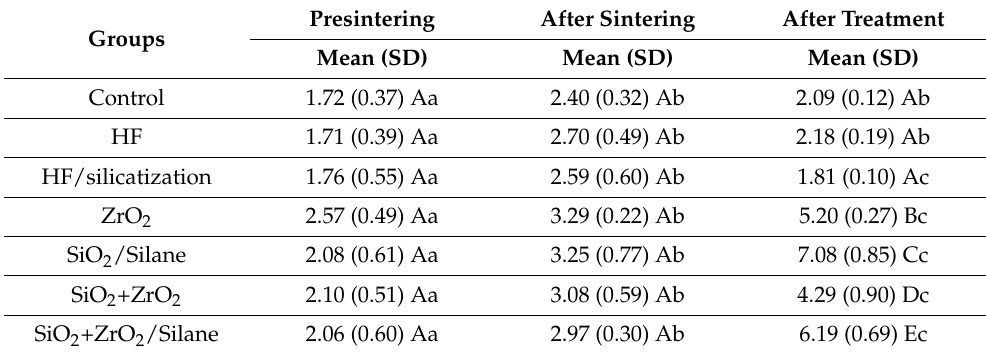
Table 2. Surface roughness (Sa) of the Y-TZP discs before sintering, after sintering, and after surface treatments. Results are presented as mean (standard deviation).